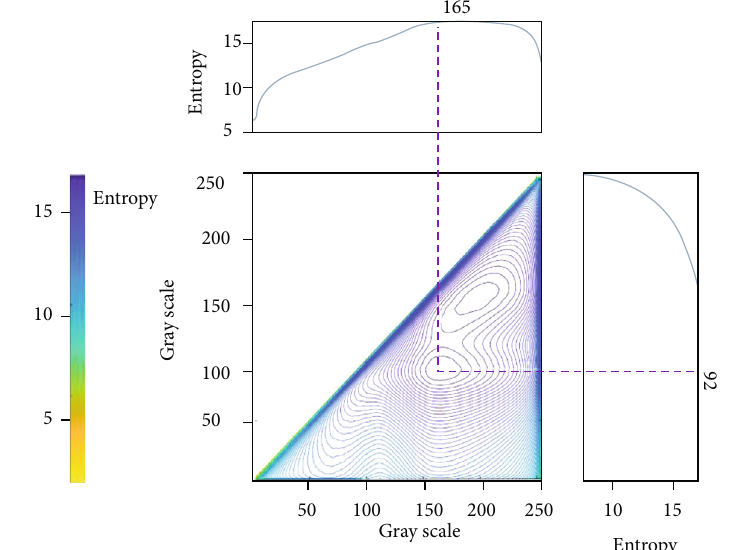
Figure 5: Distribution of segmented image